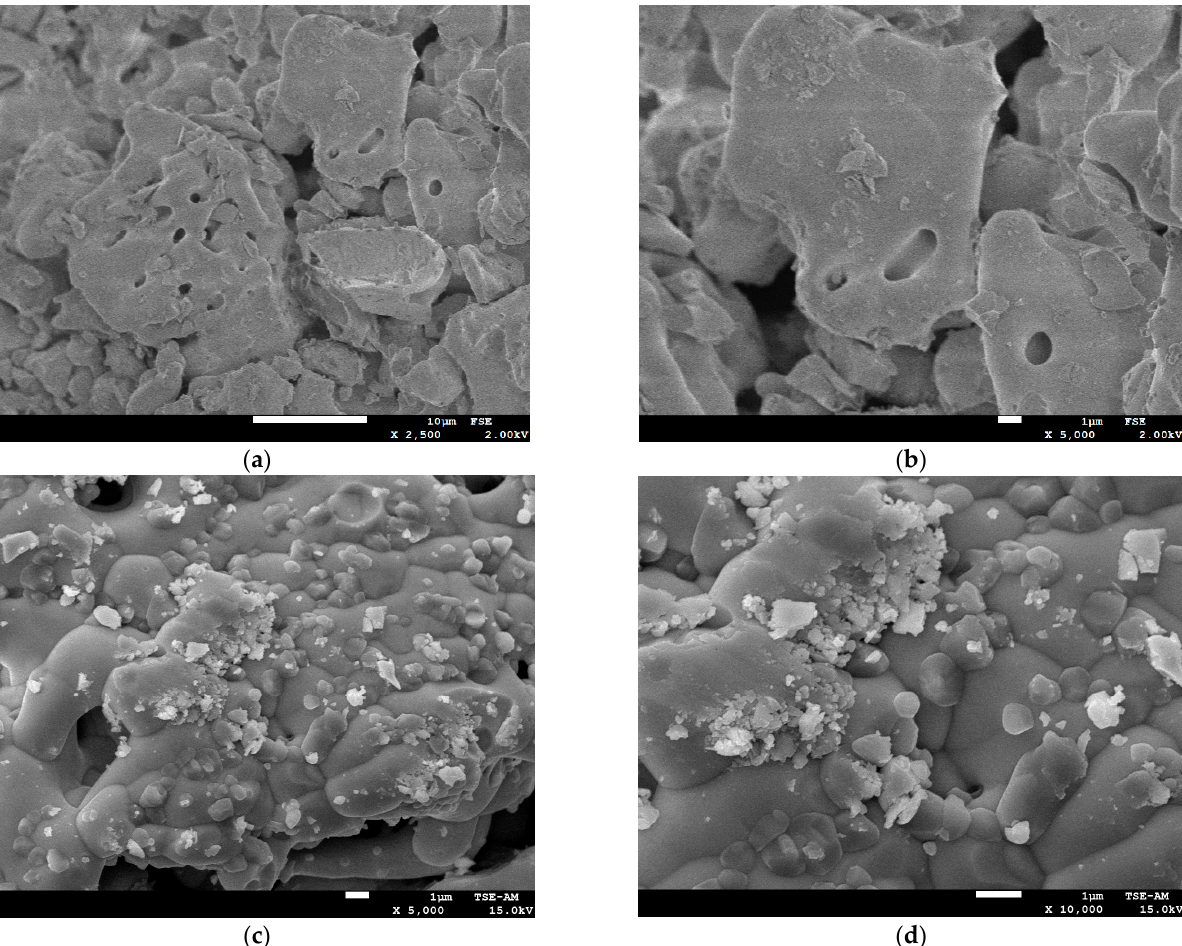
Figure 3. Raman spectra of Bi 12 ZnO 20 .